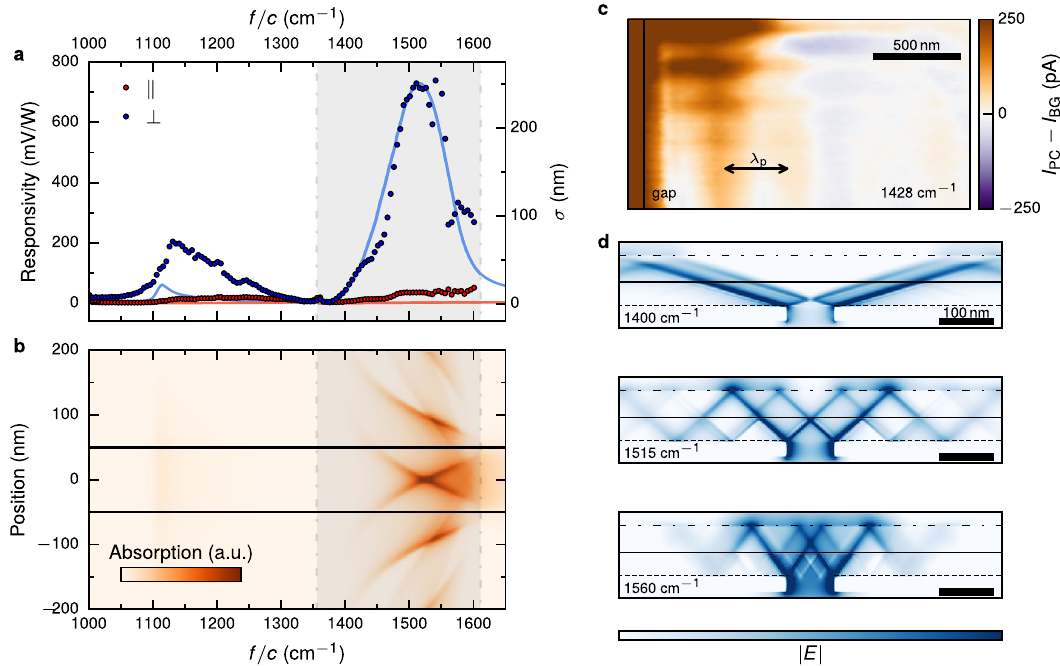
Fig. 2 Absorption and photocurrent spectra. a Responsivity spectrum for light polarization perpendicular ( parallel ) to the junction in blue ( red ). The gate voltages used here are (Vg 1 = 1.2 V and Vg 2 = − 0.21 V). The main peak which lies in the upper reststrahlen band of h-BN ( gray shaded region ) is the result of the hyperbolic phonon-polariton assisted photoresponse. Solid lines are absorption spectra simulated by FDTD. b FDTD simulation of the spatial absorption pro fi le in the vicinity of the junction as a function of the laser frequency. The spatial integral at each frequency is proportional to the simulated absorption cross section spectrum in a . c Near- fi eld photocurrent measurement with subtracted background photocurrent of a similar device with 42 nm of bottom h-BN thickness, 13 nm on top and a gap width of 50 nm. The top edge of the panel is the edge of the graphene and the gap position is indicated. The left gate is set to − 2 V and the right gate to 0.1 V. d Side views of the propagating HPPs at 1400 cm − 1 (below the maximum), 1515 cm − 1 (at the maximum) and at 1560 cm − 1 (above the maximum) atomic force microscopy tip is illuminated with an infrared laser and a near- fi eld is generated at the apex of the tip. This enables us to measure the photocurrent with a spatial resolution greatly exceeding the diffraction limit of light. The representative results are shown in Fig. 2c. The device region measured includes the gap of the split gate and one graphene edge localized at the top of the frame. The obtained photocurrent map reveals two series of sinusoidal spatial oscillations (fringes) rather than sharply peaked hot spots seen in Fig. 2b. These smooth oscillations can be explained if we recall that in an h-BN slab of small enough thickness d the HPPs are quantized into discrete eigenmodes with in-plane momenta kl = tan θ ( π l + ϕ )/ d where l = 0, 1, 2, … is the mode index and ϕ ~ 1 is a phase shift that depends on the boundary conditions (Fig. 3b and e.g., ref. 31). The collimated rays seen in Fig. 2d can be understood as coherent superpositions of